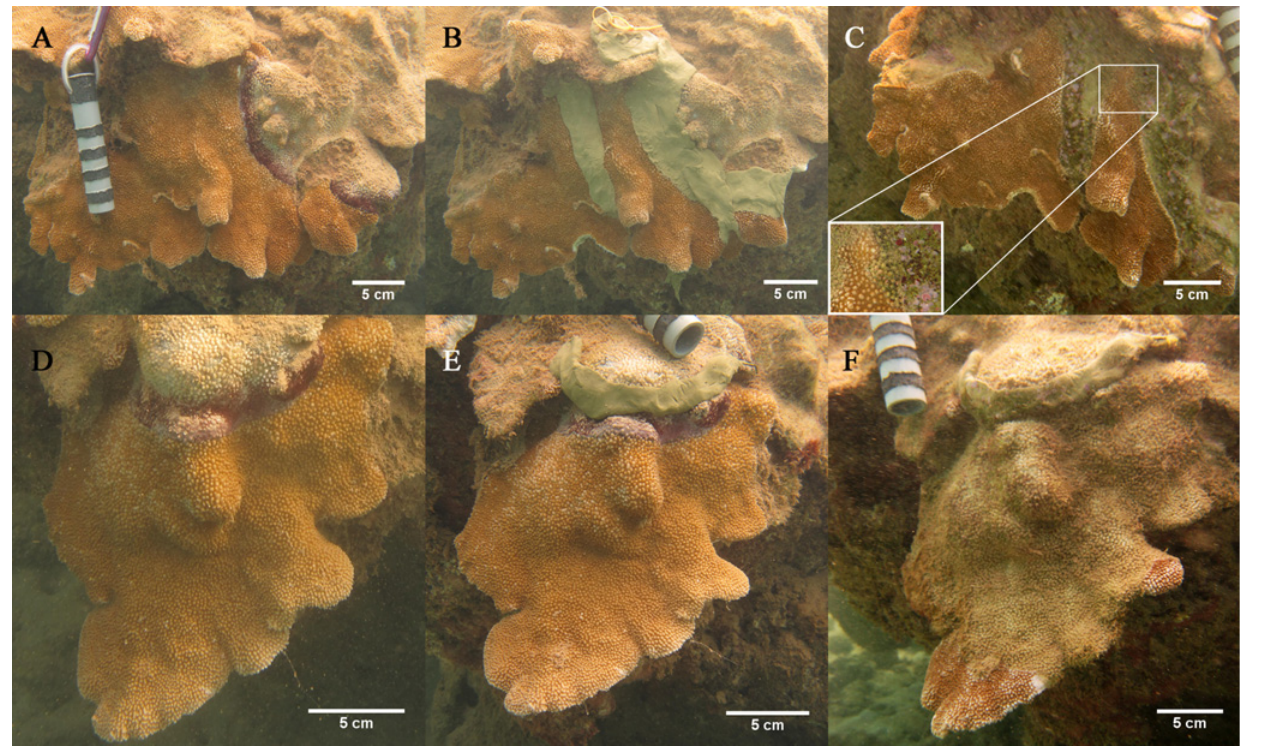
Fig 2. The lesion occlusion method of disease treatment. A) Infected M . capitata before treatment. B) Colony with marine epoxy over lesion and with a band of epoxy placed as a “ firebreak ” approximately 5 cm away. C) Same colony two months post-treatment. Note that the marine epoxy is overgrown with algae and the edge of the lesion is starting to grow over the epoxy. D) Control infected M . capitata before marking with marine epoxy. E) Colony with marine epoxy approximately 5 cm behind lesion. F) Control colony after two